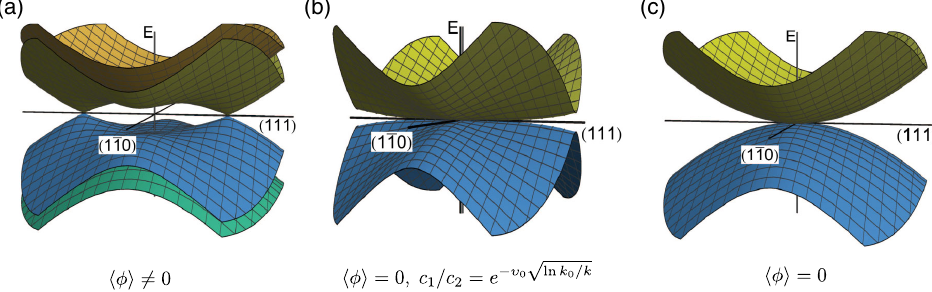
FIG. 2. Two-dimensional cut of the electronic band structure around the Gamma point (a) in the Weyl semimetal, (b) at the quantum critical point, and (c) in the quadratic band touching (Luttinger-Abrikosov-Beneslavskii) phase. In (b), we have included the effect of the irrelevant c 1 term which produces some weak dispersion along the h 111 i directions. For more details, see the text at the end of Sec. III